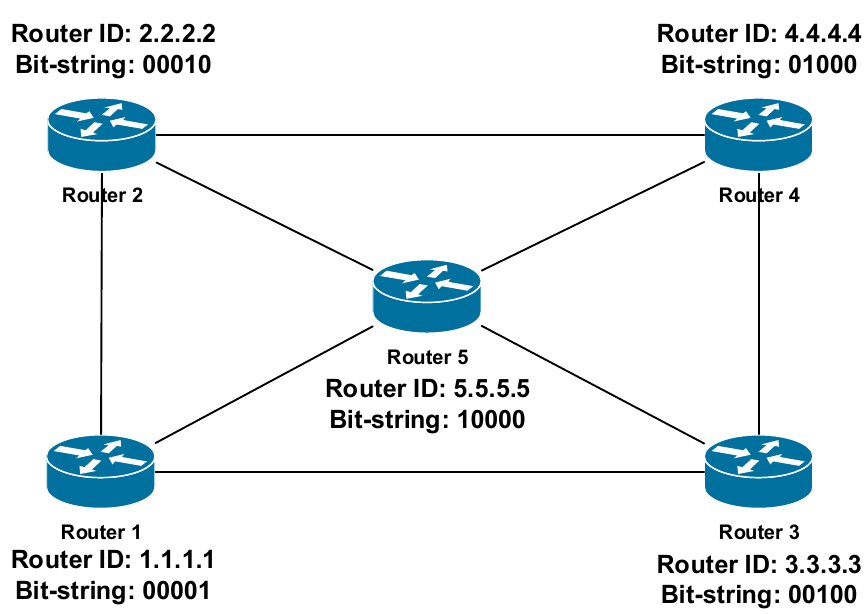
Figure 6. Allocation of Bit-Strings by the Router ID. Table 3. B-REP Table—Bit allocation according to Bit-String.